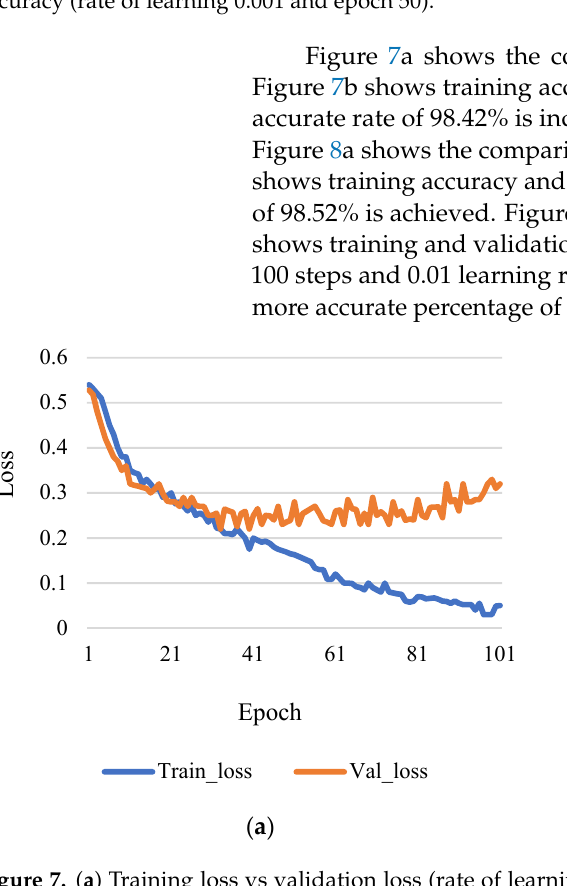
( b ) Figure 8. ( a ) Training loss vs validation loss (rate of learning 0.01 and epoch 50). ( b ) Training accuracy vs validation accu- racy (rate of learning 0.01 and epoch 50).